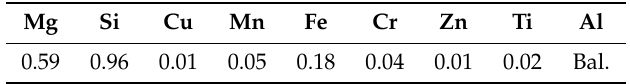
Table 1. Chemical composition of alloy used in the present study (wt